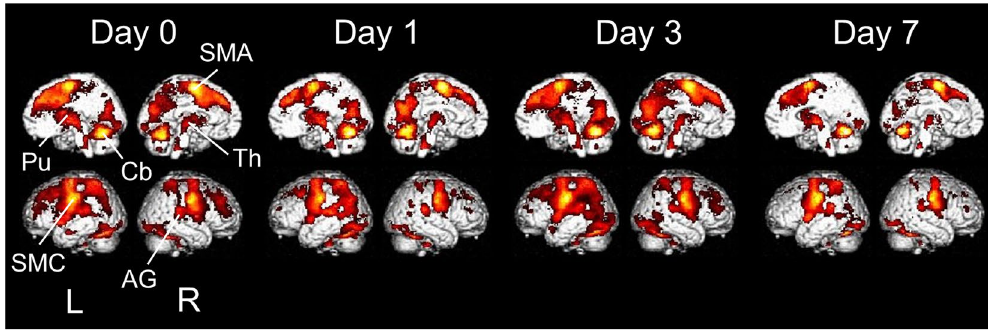
Figure 2. Activated areas during the tongue movement task projected onto the medial (top) and lateral (bottom) surfaces of the brain (n = 27) implemented in SPM12. L: left hemisphere; R: right hemisphere. SMC: sensorimotor cortex; Cb: cerebellum; Pu: putamen; Th: thalamus; SMA: supplementary motor area; AG: angular gyrus.